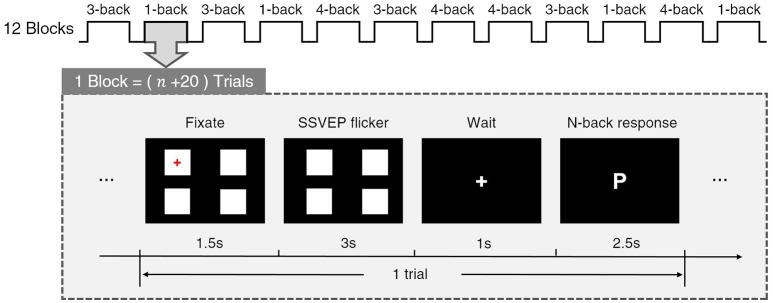
Experimental procedure. During SSVEP flicker period, four stimulus squares flickered with the frequency of 7, 11, 13, and 15 Hz respectively.